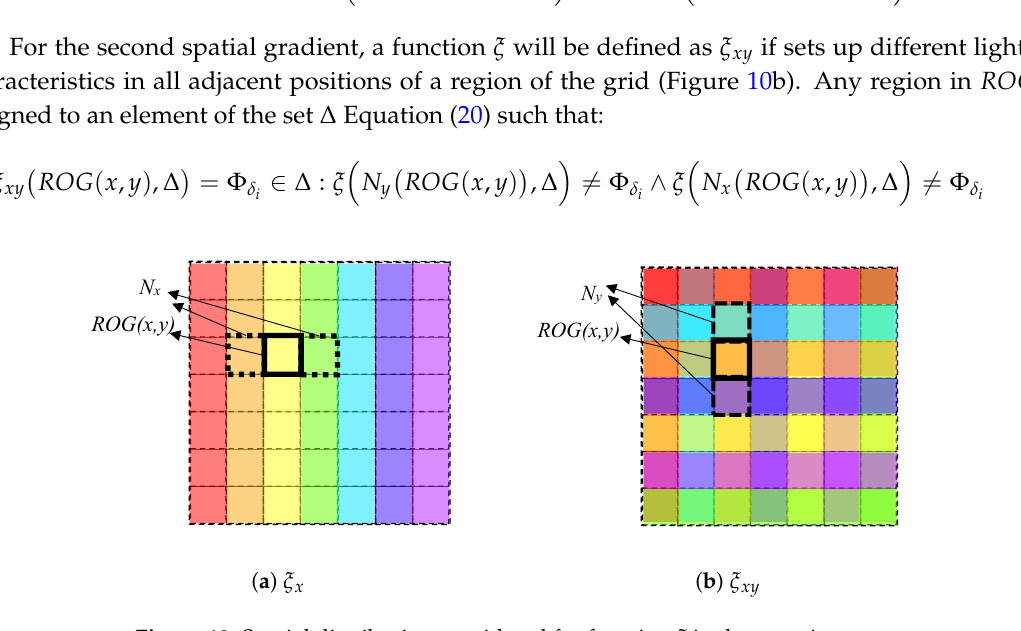
Figure 10. Spatial distribution considered for function ξ in the